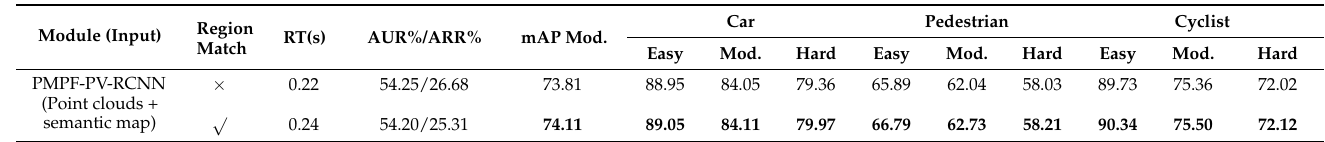
Table 9. Comparison of PMPF-PV-RCNN fusion semantic map with point cloud on the KITTI validation set. Abbreviations: run time